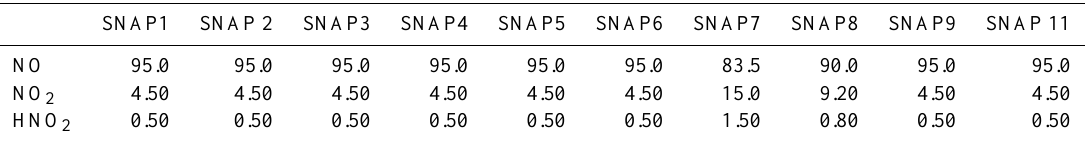
Table 2. NO x speciation (%) used in CHIMERE for each SNAP